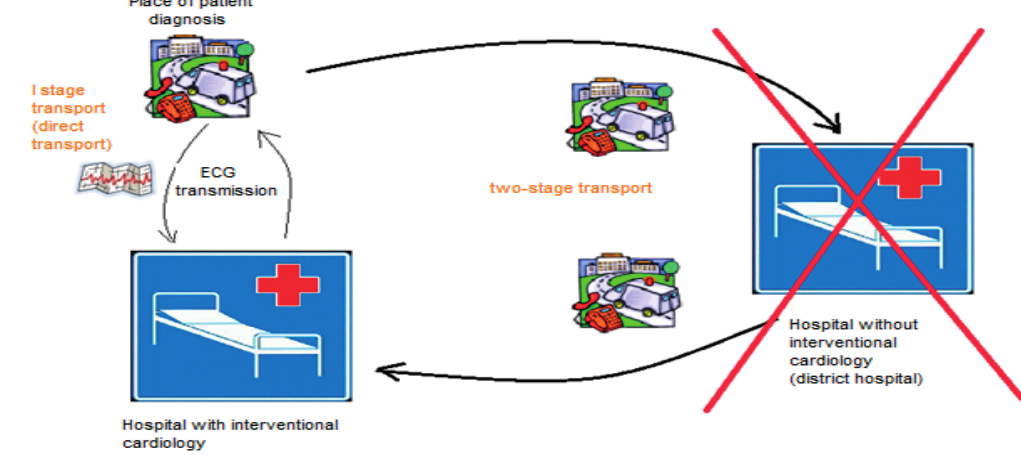
Figure 2. Scheme of a two-stage transport and one-stage transport of patients to a hospital model from Poland. Source: authors’ own